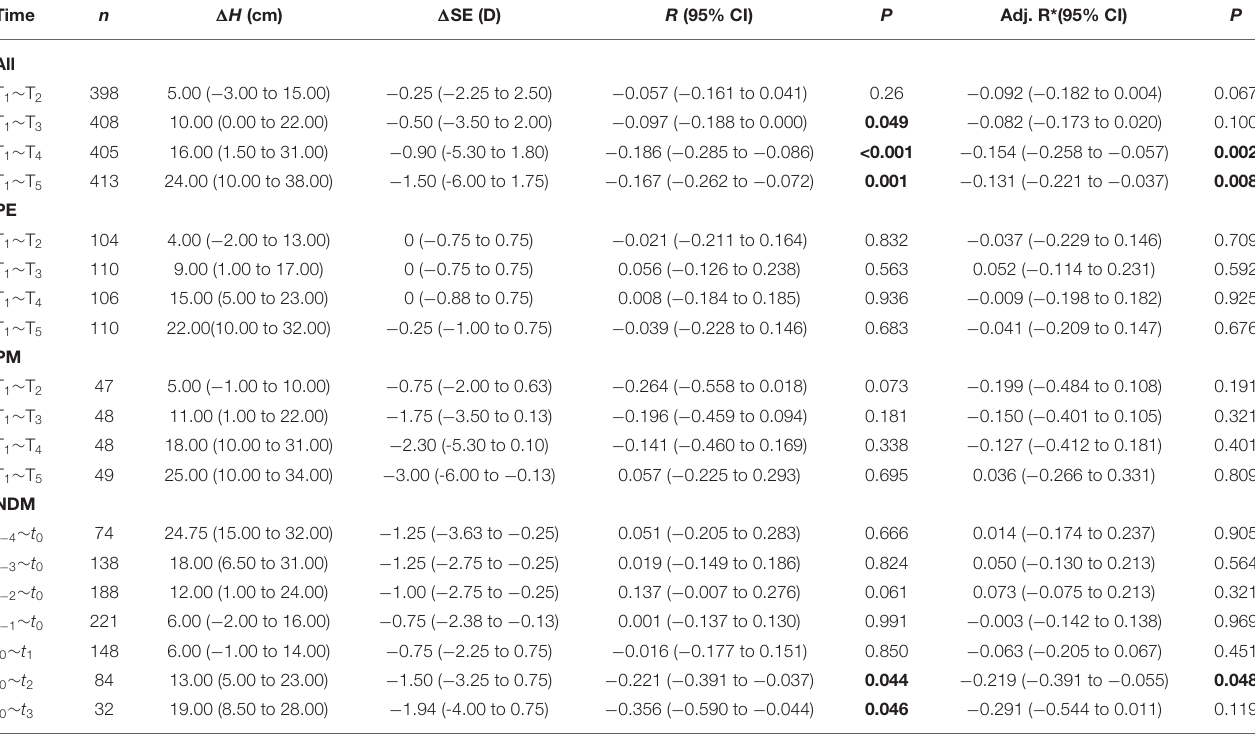
TABLE 6 | Correlation between changes in height and changes in refraction in different groups.